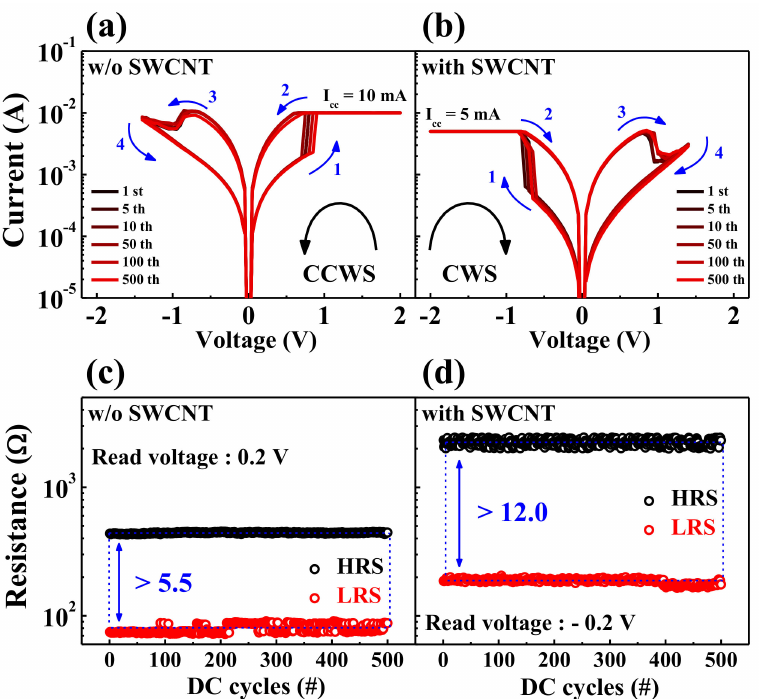
Figure 4. RS endurance characteristics of HSQ memristors w/o and w/ the embedded SWCNT random network for 5 × 10 2 DC cycles. BRS I – V curves of the HSQ memristors ( a ) w/o and ( b ) w/ the embedded SWCNT random network. Resistance endurance of the HSQ memristors ( c ) w/o and ( d ) w/ the embedded SWCNT random